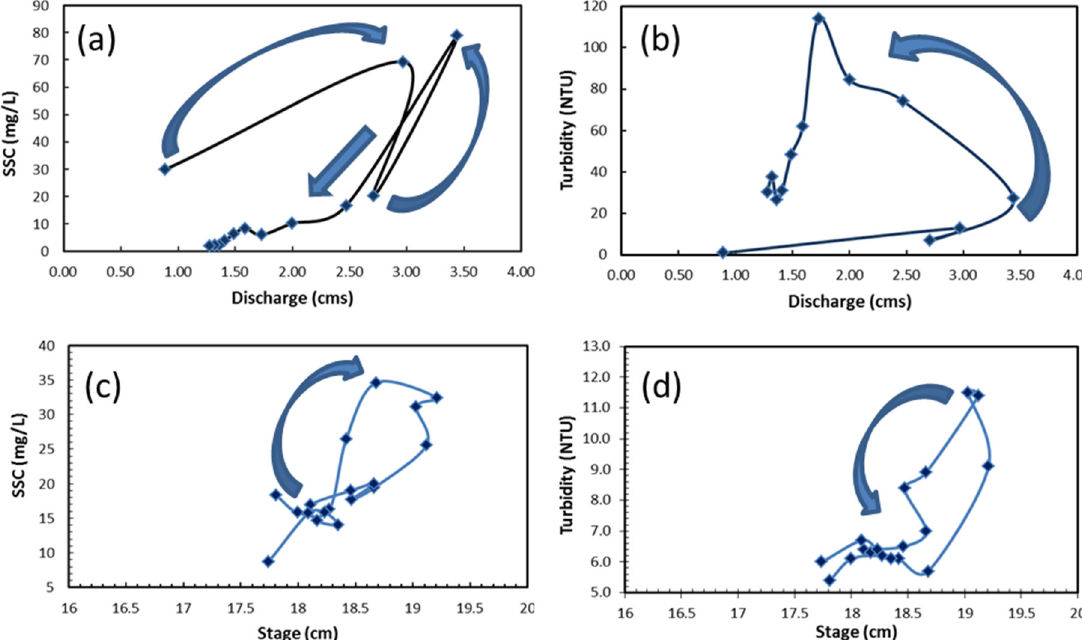
Figure 7. Examples of hysteresis loops observed for Allen Creek #1 ( a , b ) during the 4–5 March 2008 flood and Old Bald Creek #3 during the 28 April 2014 flood ( c , d ).